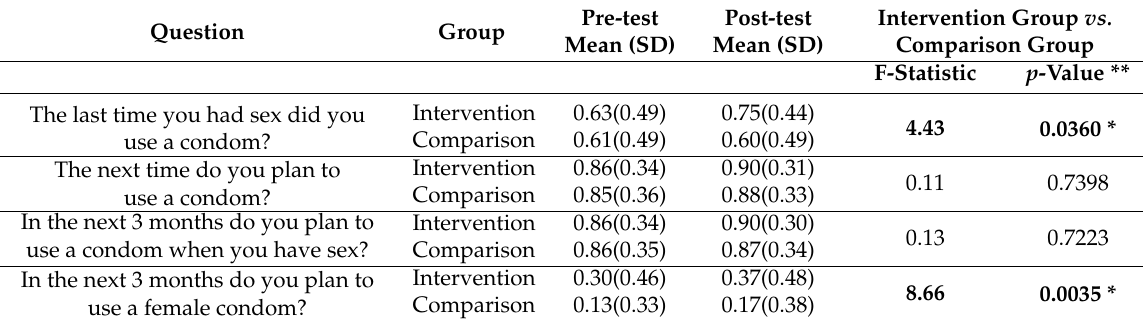
Table 3. Results of Analysis of Variance (Generalized Linear Model) of Difference of Intervention versus Comparison Group in Condom Usage.